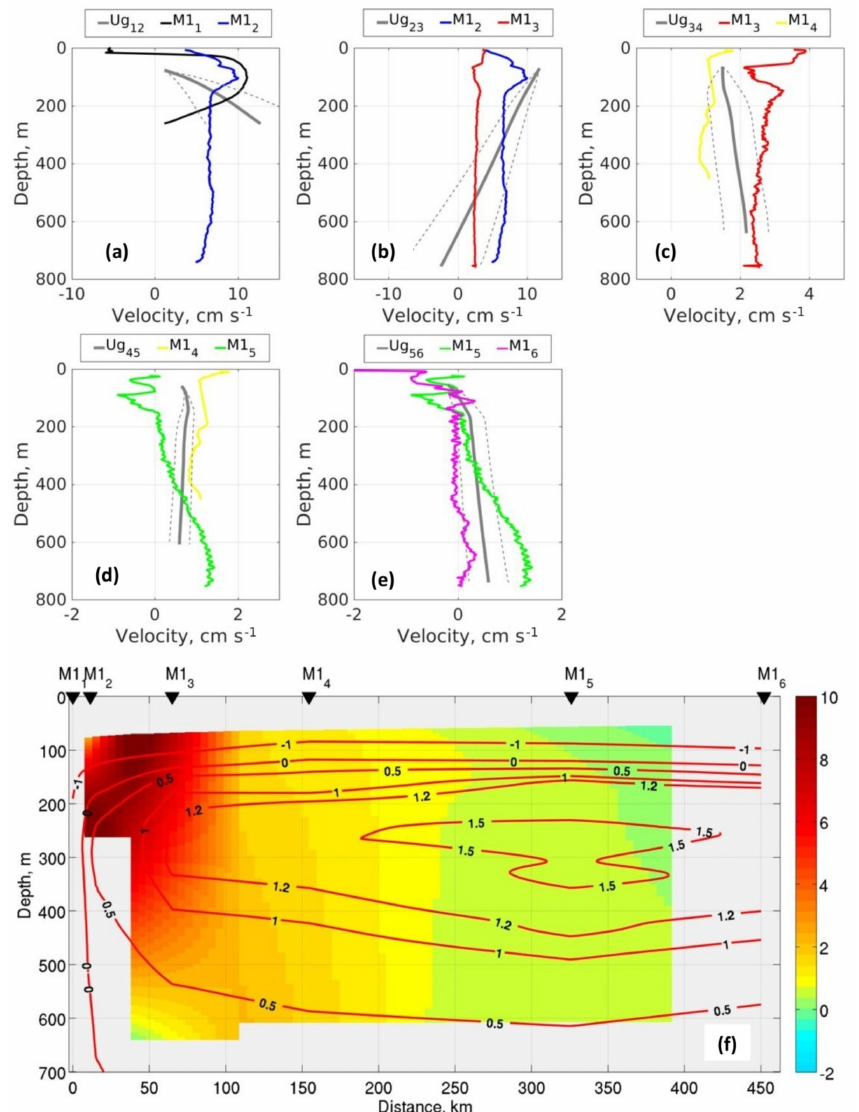
Figure 6. (a) – (e) Vertical profiles of geostrophic velocities ( Ug ; gray lines; dashed lines indicate intervals of 1 standard deviation) for each pair of moorings from the Laptev Sea slope. The 2013–2015 mean eastward velocities at six moorings are shown by color profiles. (f) Cross- slope distribution of geostrophic velocities (color, cms − 1 ) and water temperature along 125 ◦ E section (isolines, ◦ C). All geostrophic ve- locities were calculated using 2013–2015 mean temperature and salinity mooring profiles. Positive velocities are eastward. Black triangles show the mooring